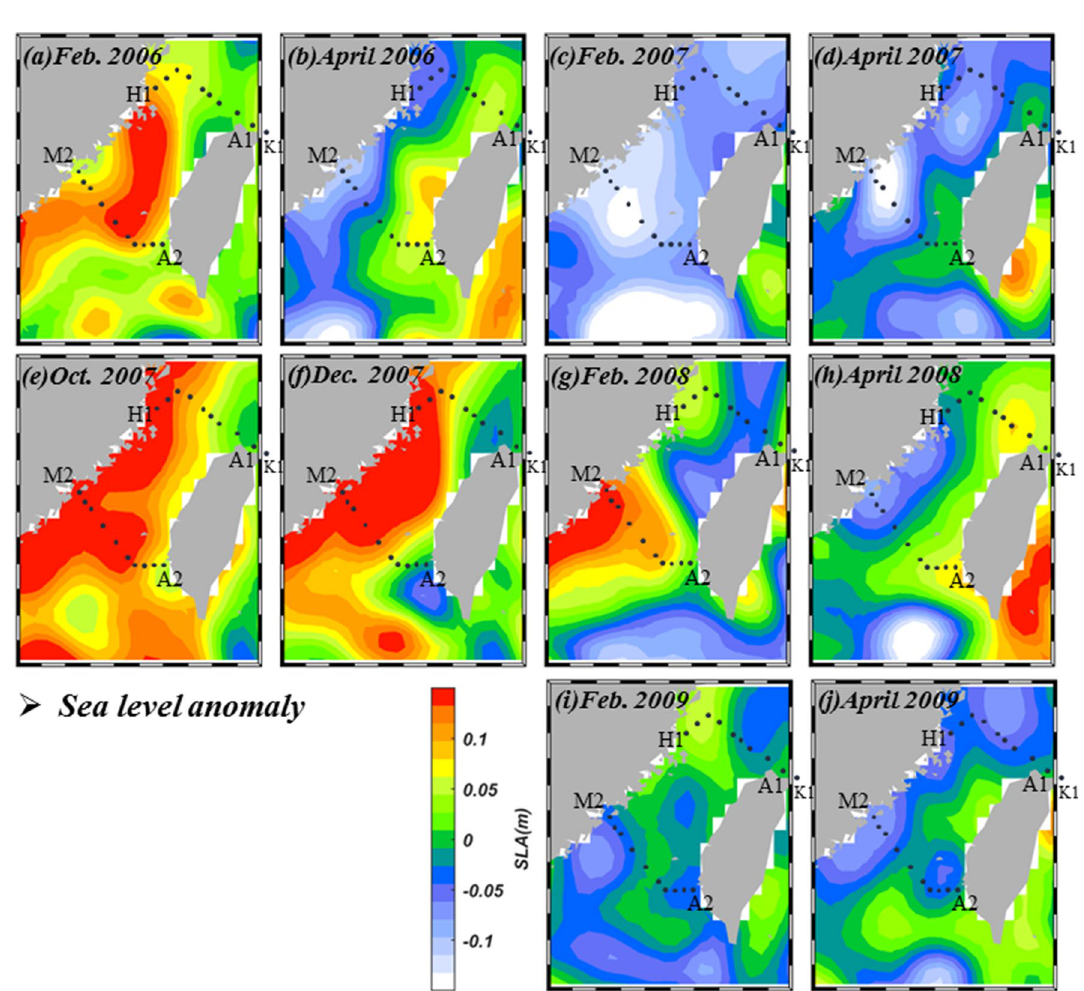
Figure 8. Monthly mean sea level anomaly in ( a ) Feb. 2006, ( b ) April 2006, ( c ) Feb. 2007, ( d ) April 2007, ( e ) Oct. 2007, ( f ) Dec. 2007, ( g ) Feb. 2008, ( h ) April 2008, ( i ) Feb. 2009 and ( j ) April 2009 in the vicinity of the study area (map generated by using the m_map toolbox in MATLAB 2019a; https ://www.mathw